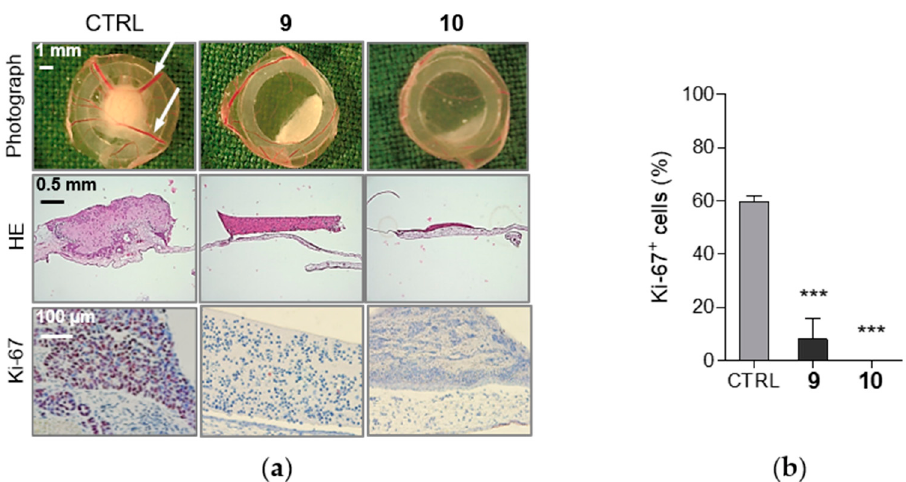
Figure 5. Compounds 9 and 10 inhibit proliferation of MCF-7 breast cancer xenografts. ( a ) MCF-7 breast cancer xenografts were topically treated with 9 or 10 (10 µ M) for three days. 24 h later, xenografts were extracted (1st row), white arrows indicate tumor nourishing blood vessels. Para ffi n-embedded MCF-7 xenografts were stained with hematoxylin and eosin (HE, 2nd row), original magnification 50 × . The proliferation was analyzed by immunohistochemical staining of xenografts using proliferation marker, Ki-67 antigen (red nuclear stain, 3rd row). Representative microscopic pictures are shown, original magnification 200 × . ( b ) The graph demonstrates the percentage of the Ki-67 positive, proliferating cells based on immunohistochemical staining of xenografts as described in ( a ). To calculate the proportion of marker positive and negative cells, 100–400 cells per tumor were evaluated. Data are mean ± SEM of n = 3 tumors / group. *** p < 0.001, significantly di ff erent from drug-free control (CTRL).